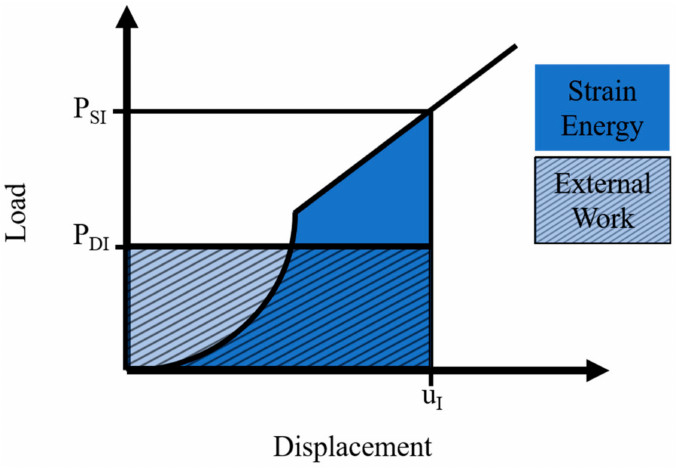
Figure 4. Energy